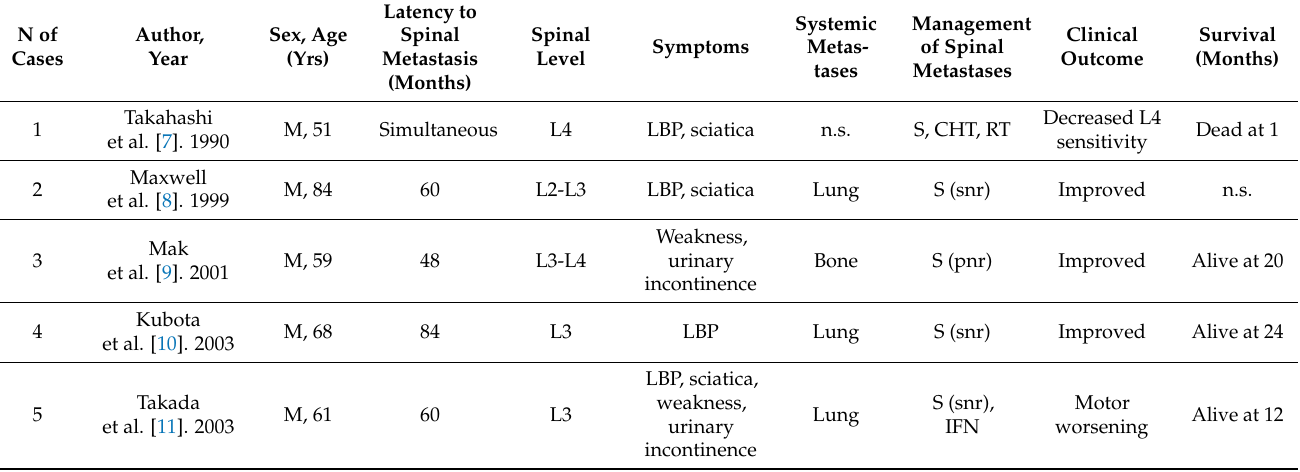
Table 1. Reported cases of intradural extramedullary (IDEM) spinal metastasis from renal cell